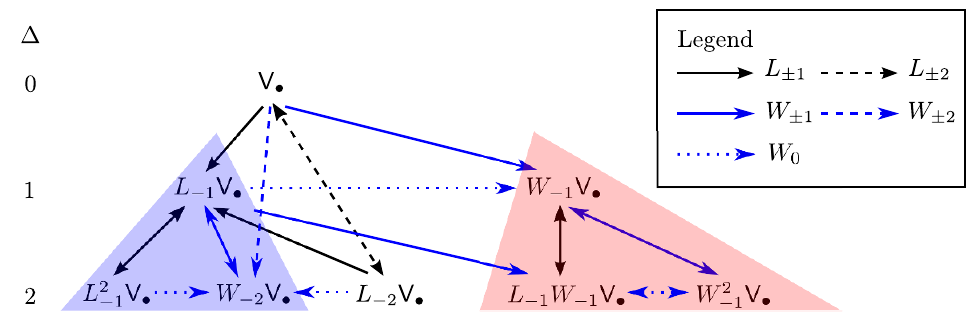
Figure 6 . Structure of the (cid:12)rst 3 levels of the simple puncture for N = 1 and k = 3 which implies (cid:1) = w = 0. For c = 2, one quotients out the submodule (shaded in red) generated by W (cid:0) 1 V (cid:15) . For c 6 = 2, i.e. for Q 6 = 0, one should quotient out the submodule generated by the vector ( W (cid:0) 1 + Q L (cid:0) 1 ) V (cid:15) instead. We remark that the singular vector L (cid:0) 1 V (cid:15) generates an indecomposable 2 submodule, shaded in blue, whose elements all have zero norm. If we were to quotient out the zero norm states as well, then we would obtain the identity representation. The color and type of the of the arrows indicates which generators are acting, as depicted in the